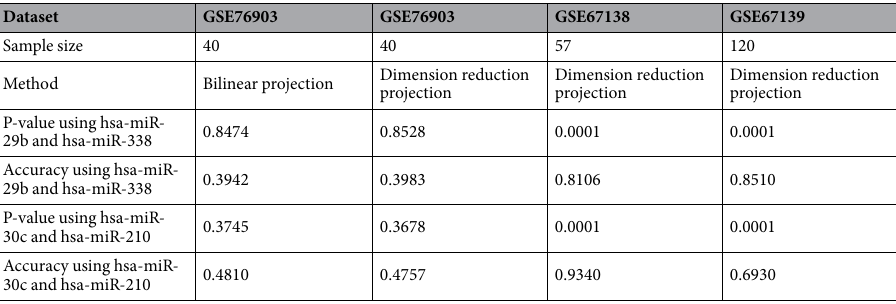
Table 2. Independent validations on dataset GSE76903 36 , GSE67138 and GSE67139 using the selected miRNA pairs considered to be